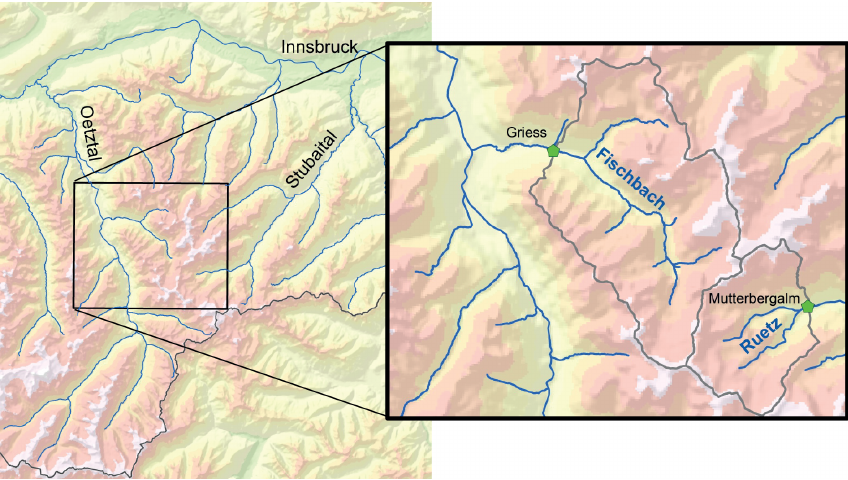
Figure 1. Location of the Fischbach and Ruetz mountain stream catchments in the Stubai Alps of Tyrol in western Austria. The measuring sites are indicated with a green pentagon, and the catchment boundaries are marked with a gray line. (Source of topographic map: Abteilung Geoinformation, Amt der Tiroler Landesregierung; https://www.tirol.gv.at/data.)